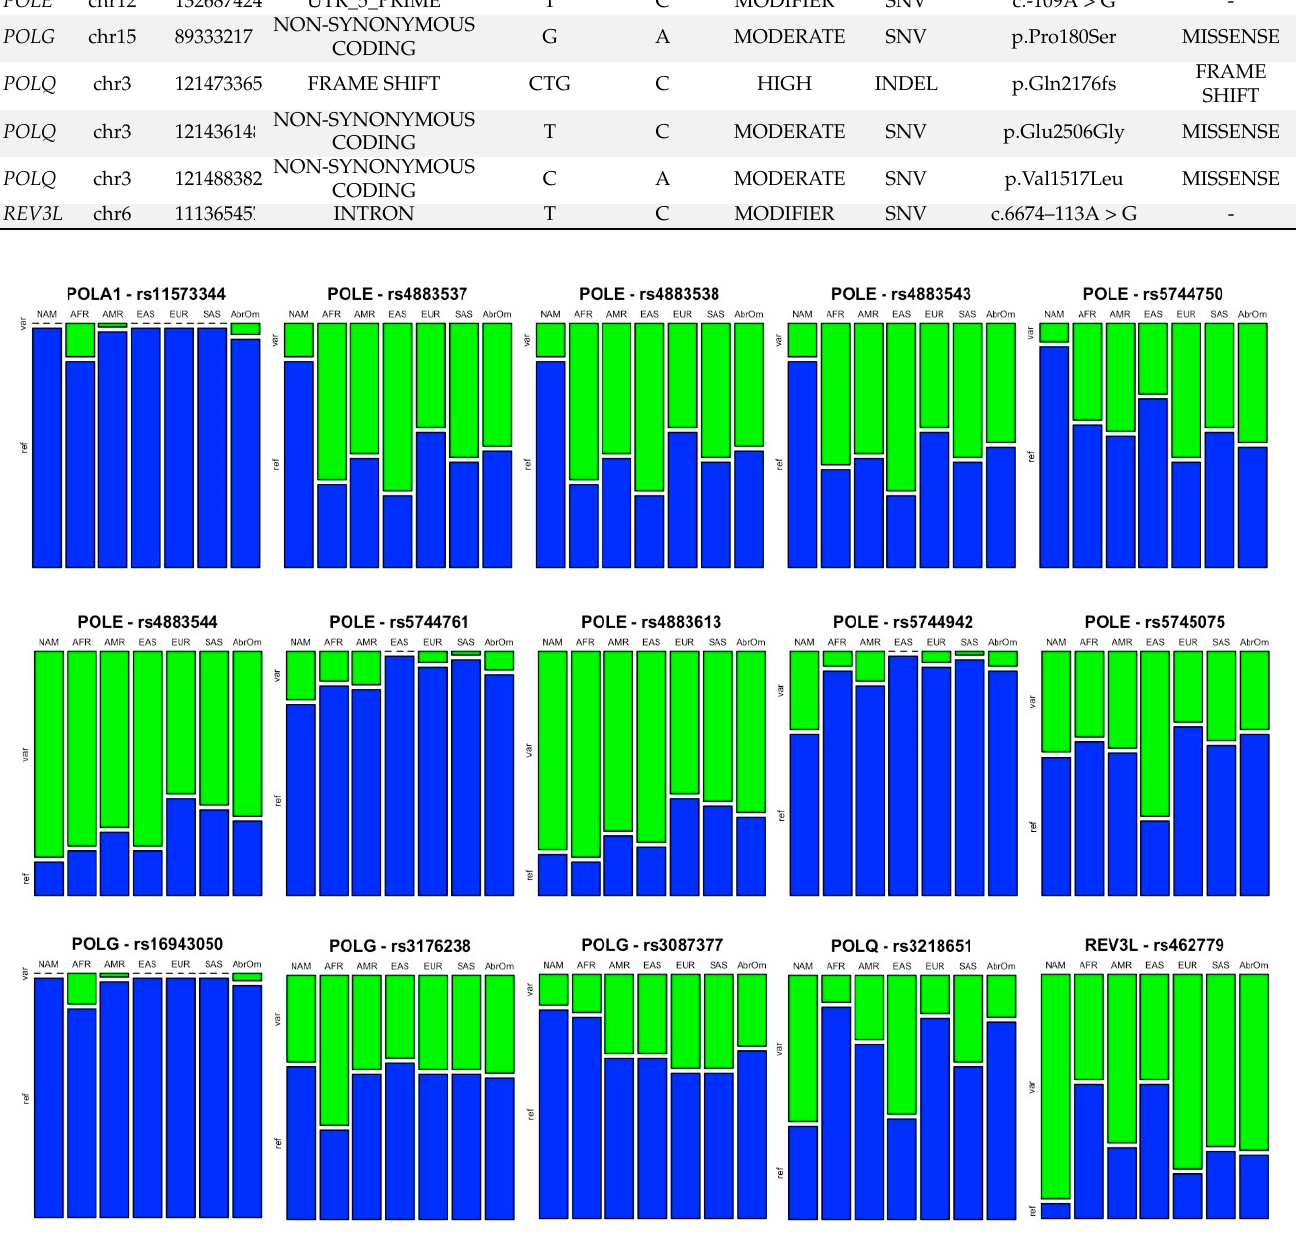
Figure 1. Wild-type and mutant genotype Mosaic plot for each variant with statistical significance in the comparison analysis between the seven study populations (AFR, AMR, EAS, EUR, SAS, NAT and ABraOM).